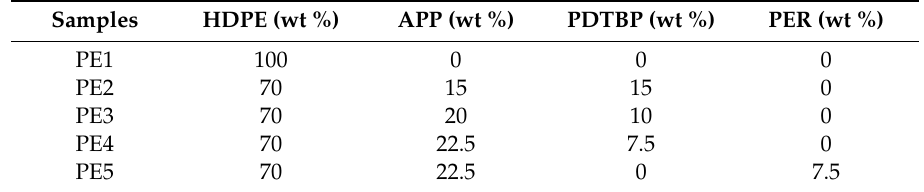
Table 1. Formulations of the flame-retardant high-density polyethylene (HDPE) / intumescent flame retardant (IFR)